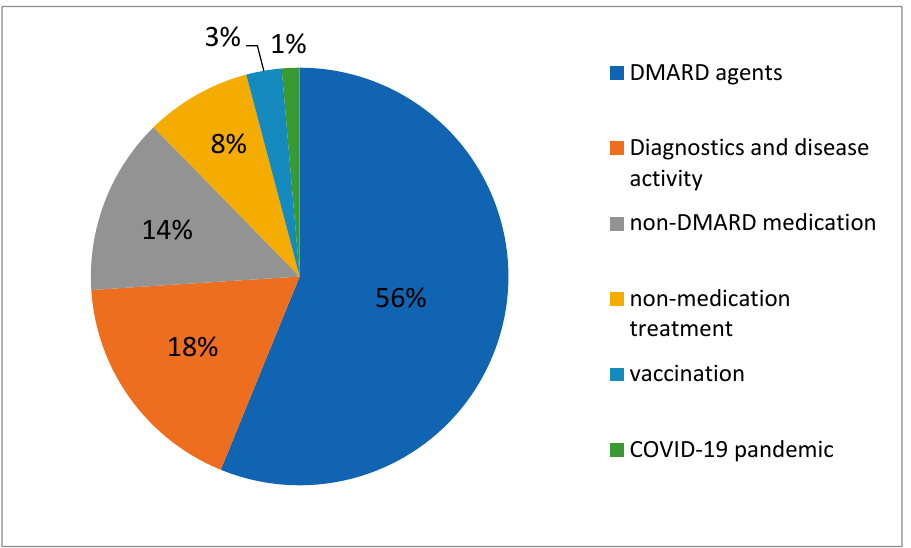
Figure 1. Proportions of study objectives.